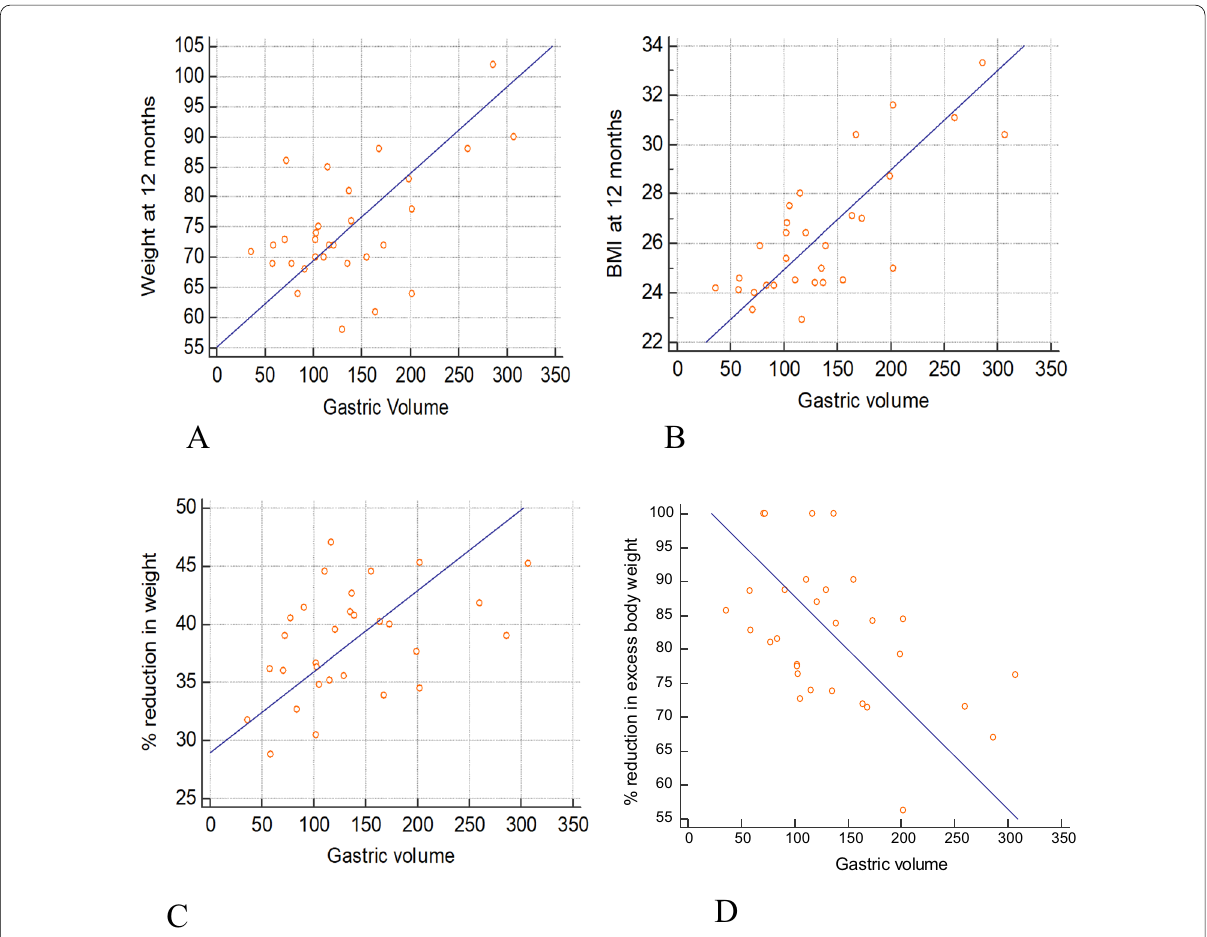
Fig. 2 A Scatter diagram revealing a significant mild positive correlation between gastric volume and the weight loss at 12 months (rs 0.37, P 0.04). B Scatter diagram revealing a significant strong positive correlation between gastric volume and the BMI reduction at = = 12 months (rs 0.693, P < 0.0001). C Scatter diagram revealing a significant moderate positive correlation between gastric volume and the ∆ weight = at 12 months (rs 0.45, P 0.013). D Scatter diagram revealing a significant moderate inverse correlation between gastric volume and the ∆ excess = = weight at 12 months (rs 0.45, P 0.013) = =